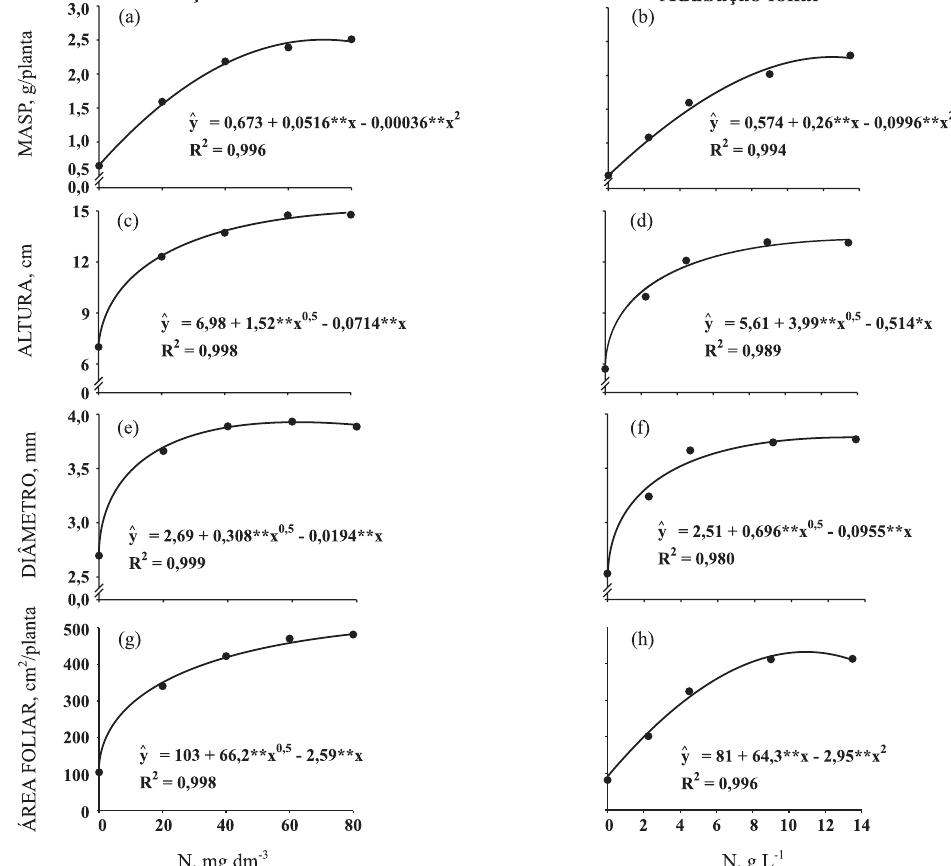
Figura 1. Matéria seca da parte aérea – MSPA, altura, diâmetro e área foliar de mudas de cacaueiro, aos 145 dias, em função da dose de nitrogênio e forma de adubação: no substrato ou foliar. **, significativo a 1 % pelo teste